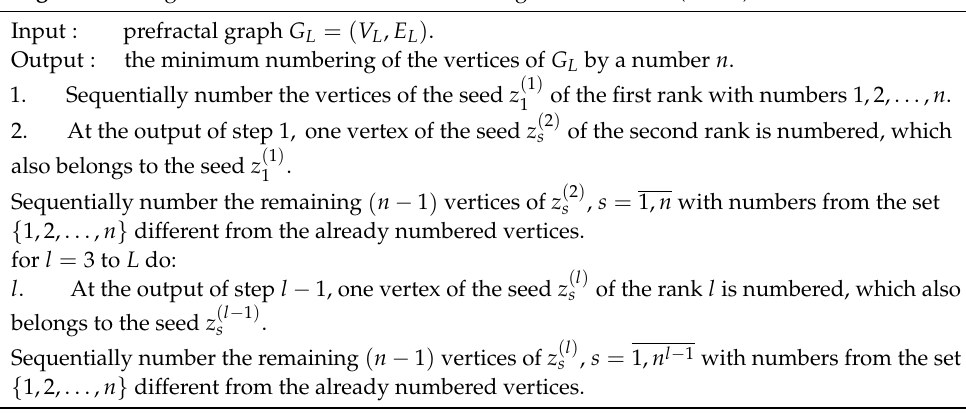
Algorithm 1 Algorithm for the Minimal Numbering of the Vertices (NUM)